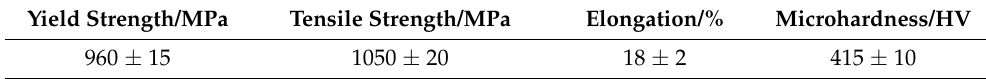
Table 2. Mechanical properties of the test steel. Table 1. Chemical composition (wt%) of the test steel.